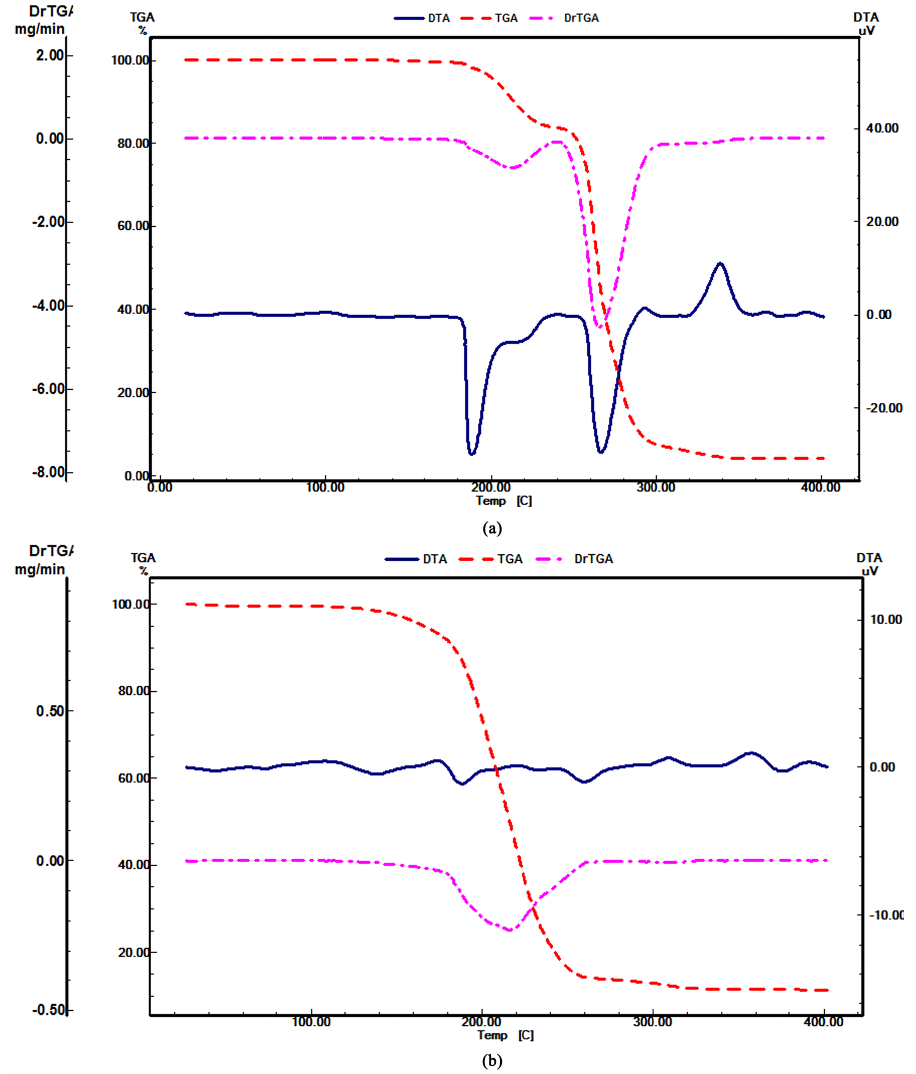
Figure 1. TG/DTG/DTA curves of. a) Un-irradiated InAcAc; b) γ-irradiated InAcAc (10 2 kGy). Table 1. TG/DTG/DTA data of indium acetylacetonate (In